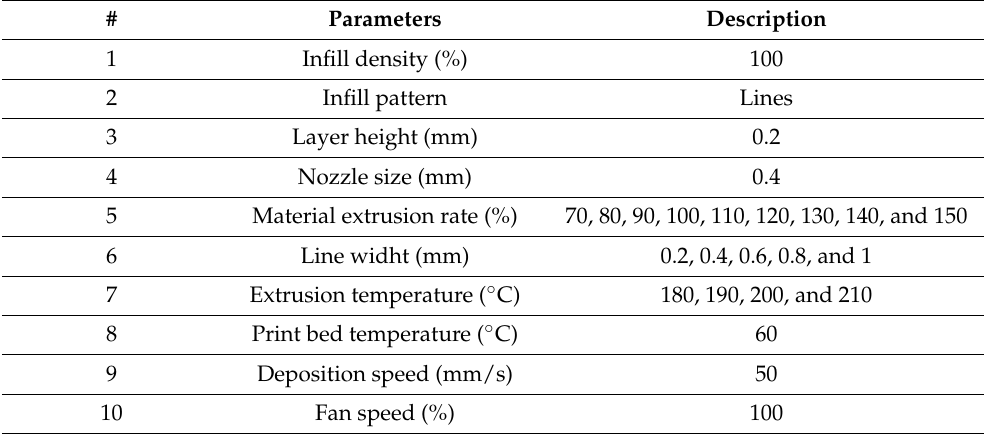
Table 2. Processing parameters for GPLA